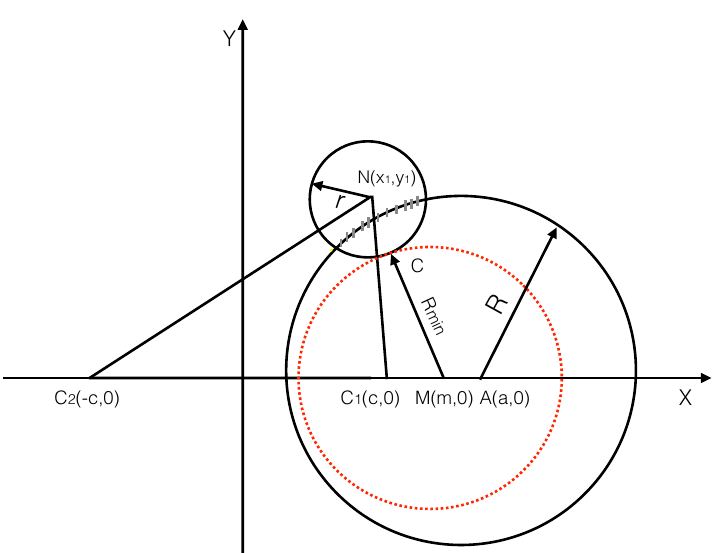
Fig. 3 Mathematical model for explaining the detection